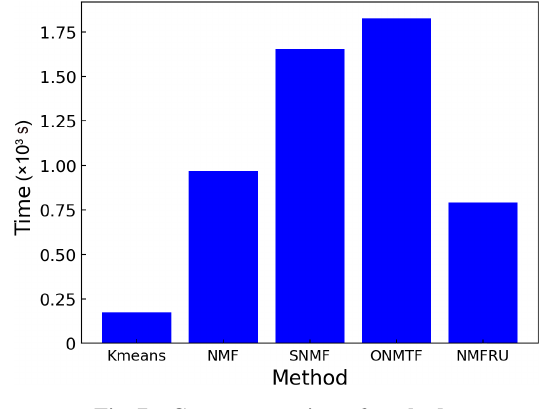
Fig. 7 Convergence time of methods. Table 3 Largest ten communities with its polarity ratio.